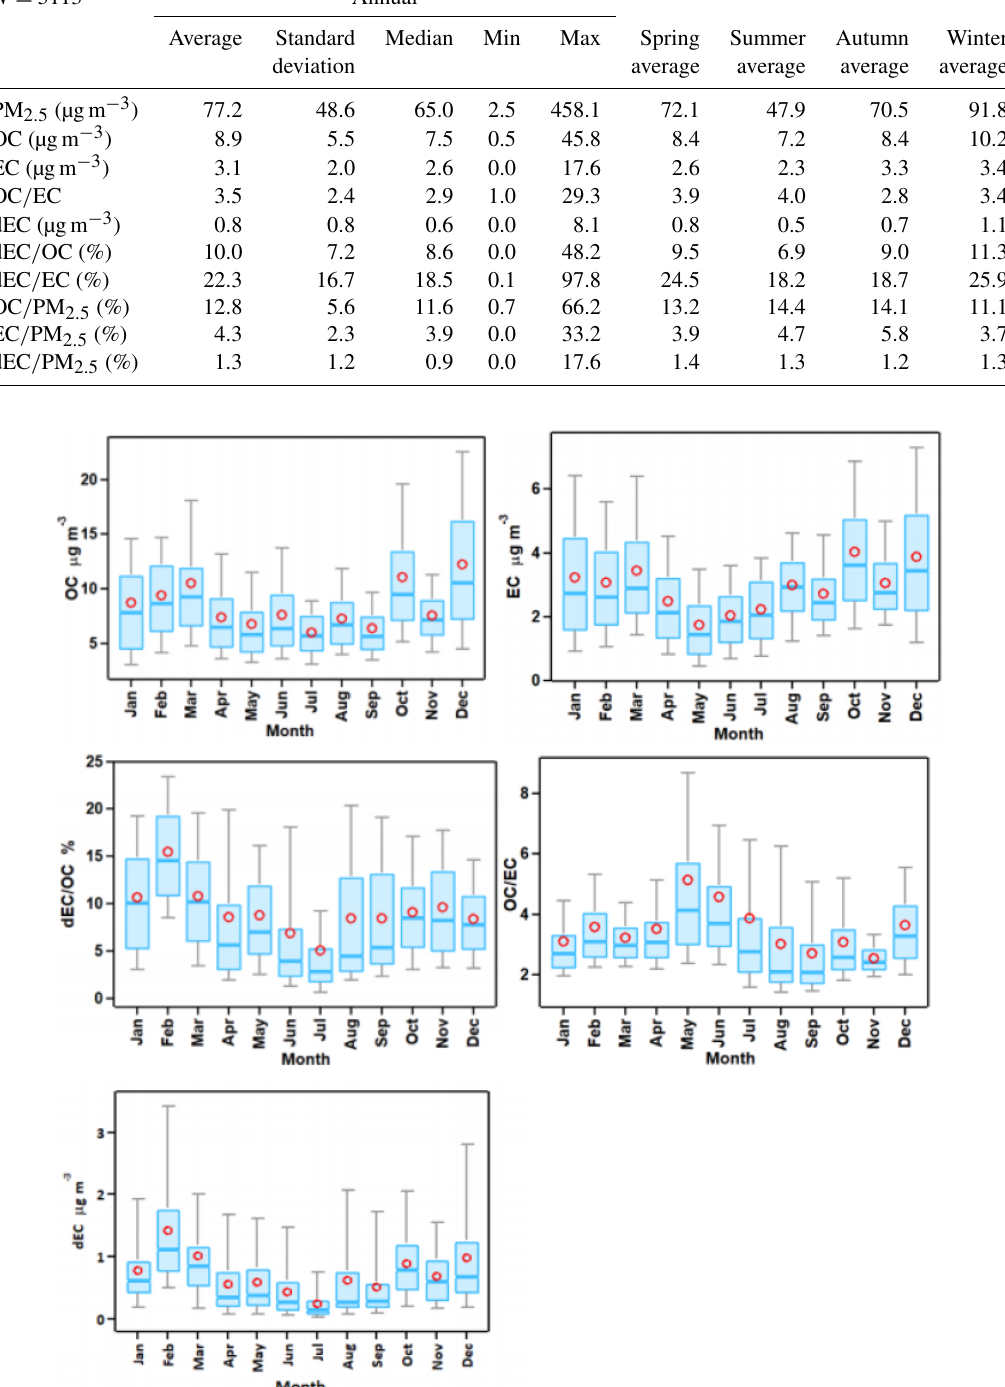
Figure 5. Monthly variations in OC, EC and dEC and dEC / OC and OC / EC ratios at NUIST from June 2015 to August 2016. The boundary of the box indicates the 25% and 75% percentile, respectively. The lower and upper whiskers indicate the 10% and 90% percentile, respectively. The red circle within the box marks the average, while the line within the box marks the